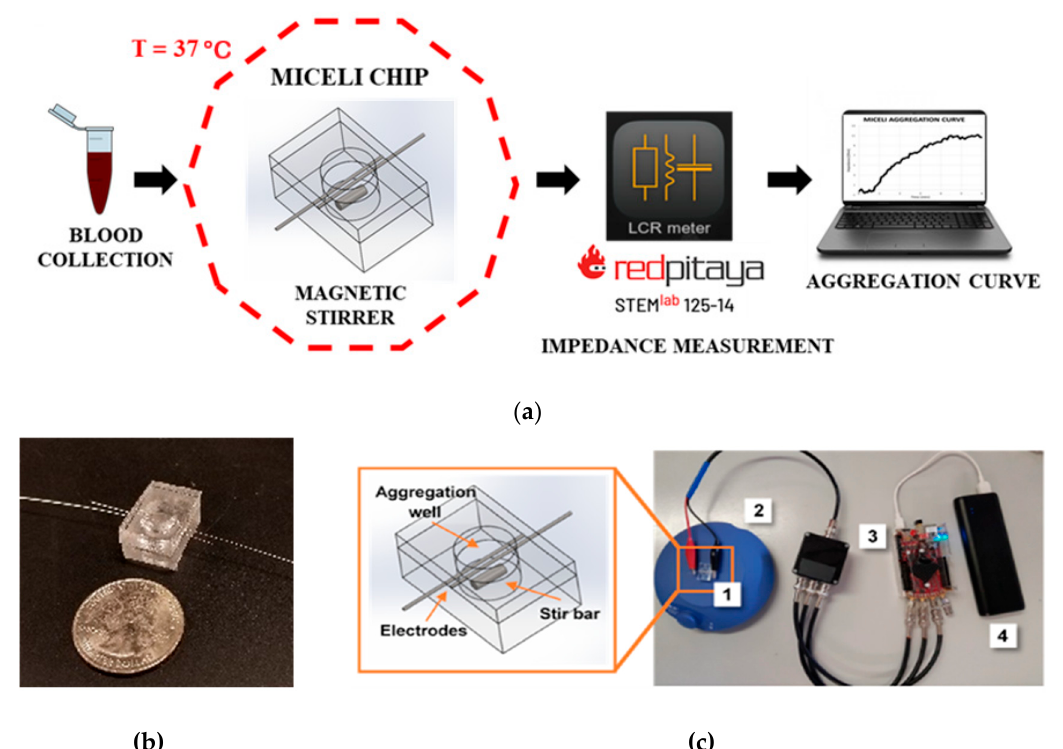
Figure 9. The MICELI system, a multicomponent prototype of the miniature impedance aggregometer: ( a ) workflow of the impedance aggregometry test using the MICELI system; ( b ) fully assembled MICELI cartridge; ( c ) the MICELI system components in a portable setup: 1—MICELI cartridge and its CAD drawing, 2—magnetic stirrer, 3—impedance analyzer, 4—power supply.